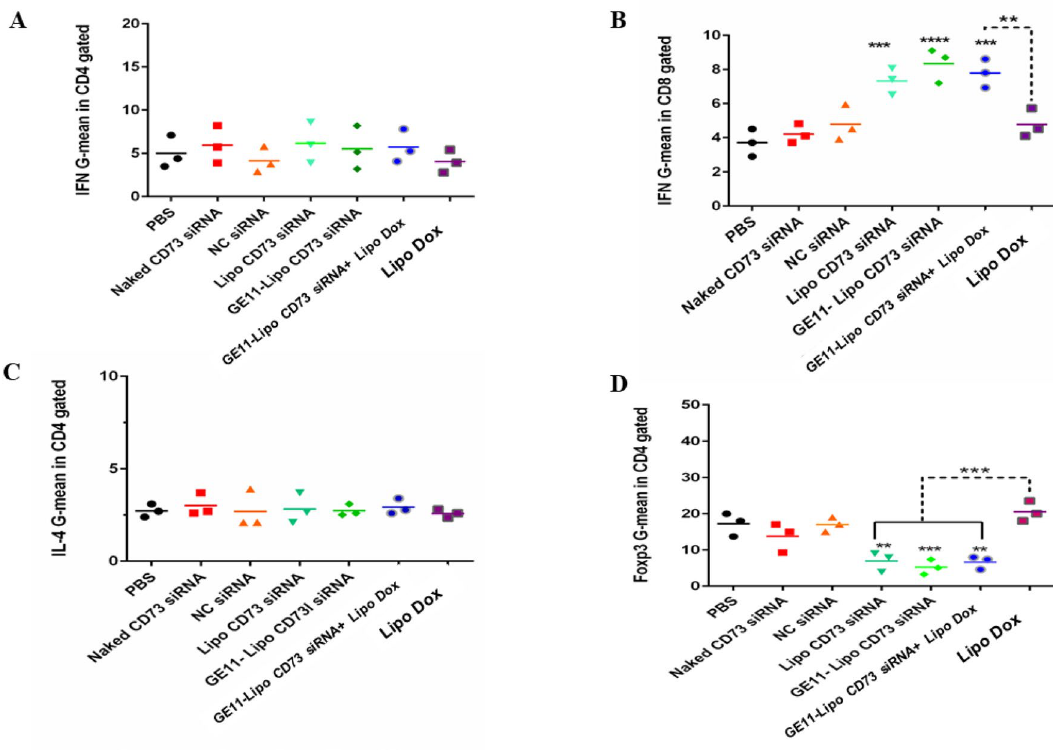
Figure 9. Intracellular cytokine profile of tumor-infiltrated lymphocytes (TILs). Two days after the last injection at the fourth week, three mice from each treatment group were sacrificed and tumor tissue cells were isolated. Isolated cells were stained with intracellular markers. Fluorescence intensity (geometric mean) of cytokines including IL-4, IFN-γ, and FoxP3 were assessed by flow cytometry. ( A , C ) Different formulations had not any significant differences on the geometric mean of IFN and IL-4 in the CD4 + gated cells. ( B )